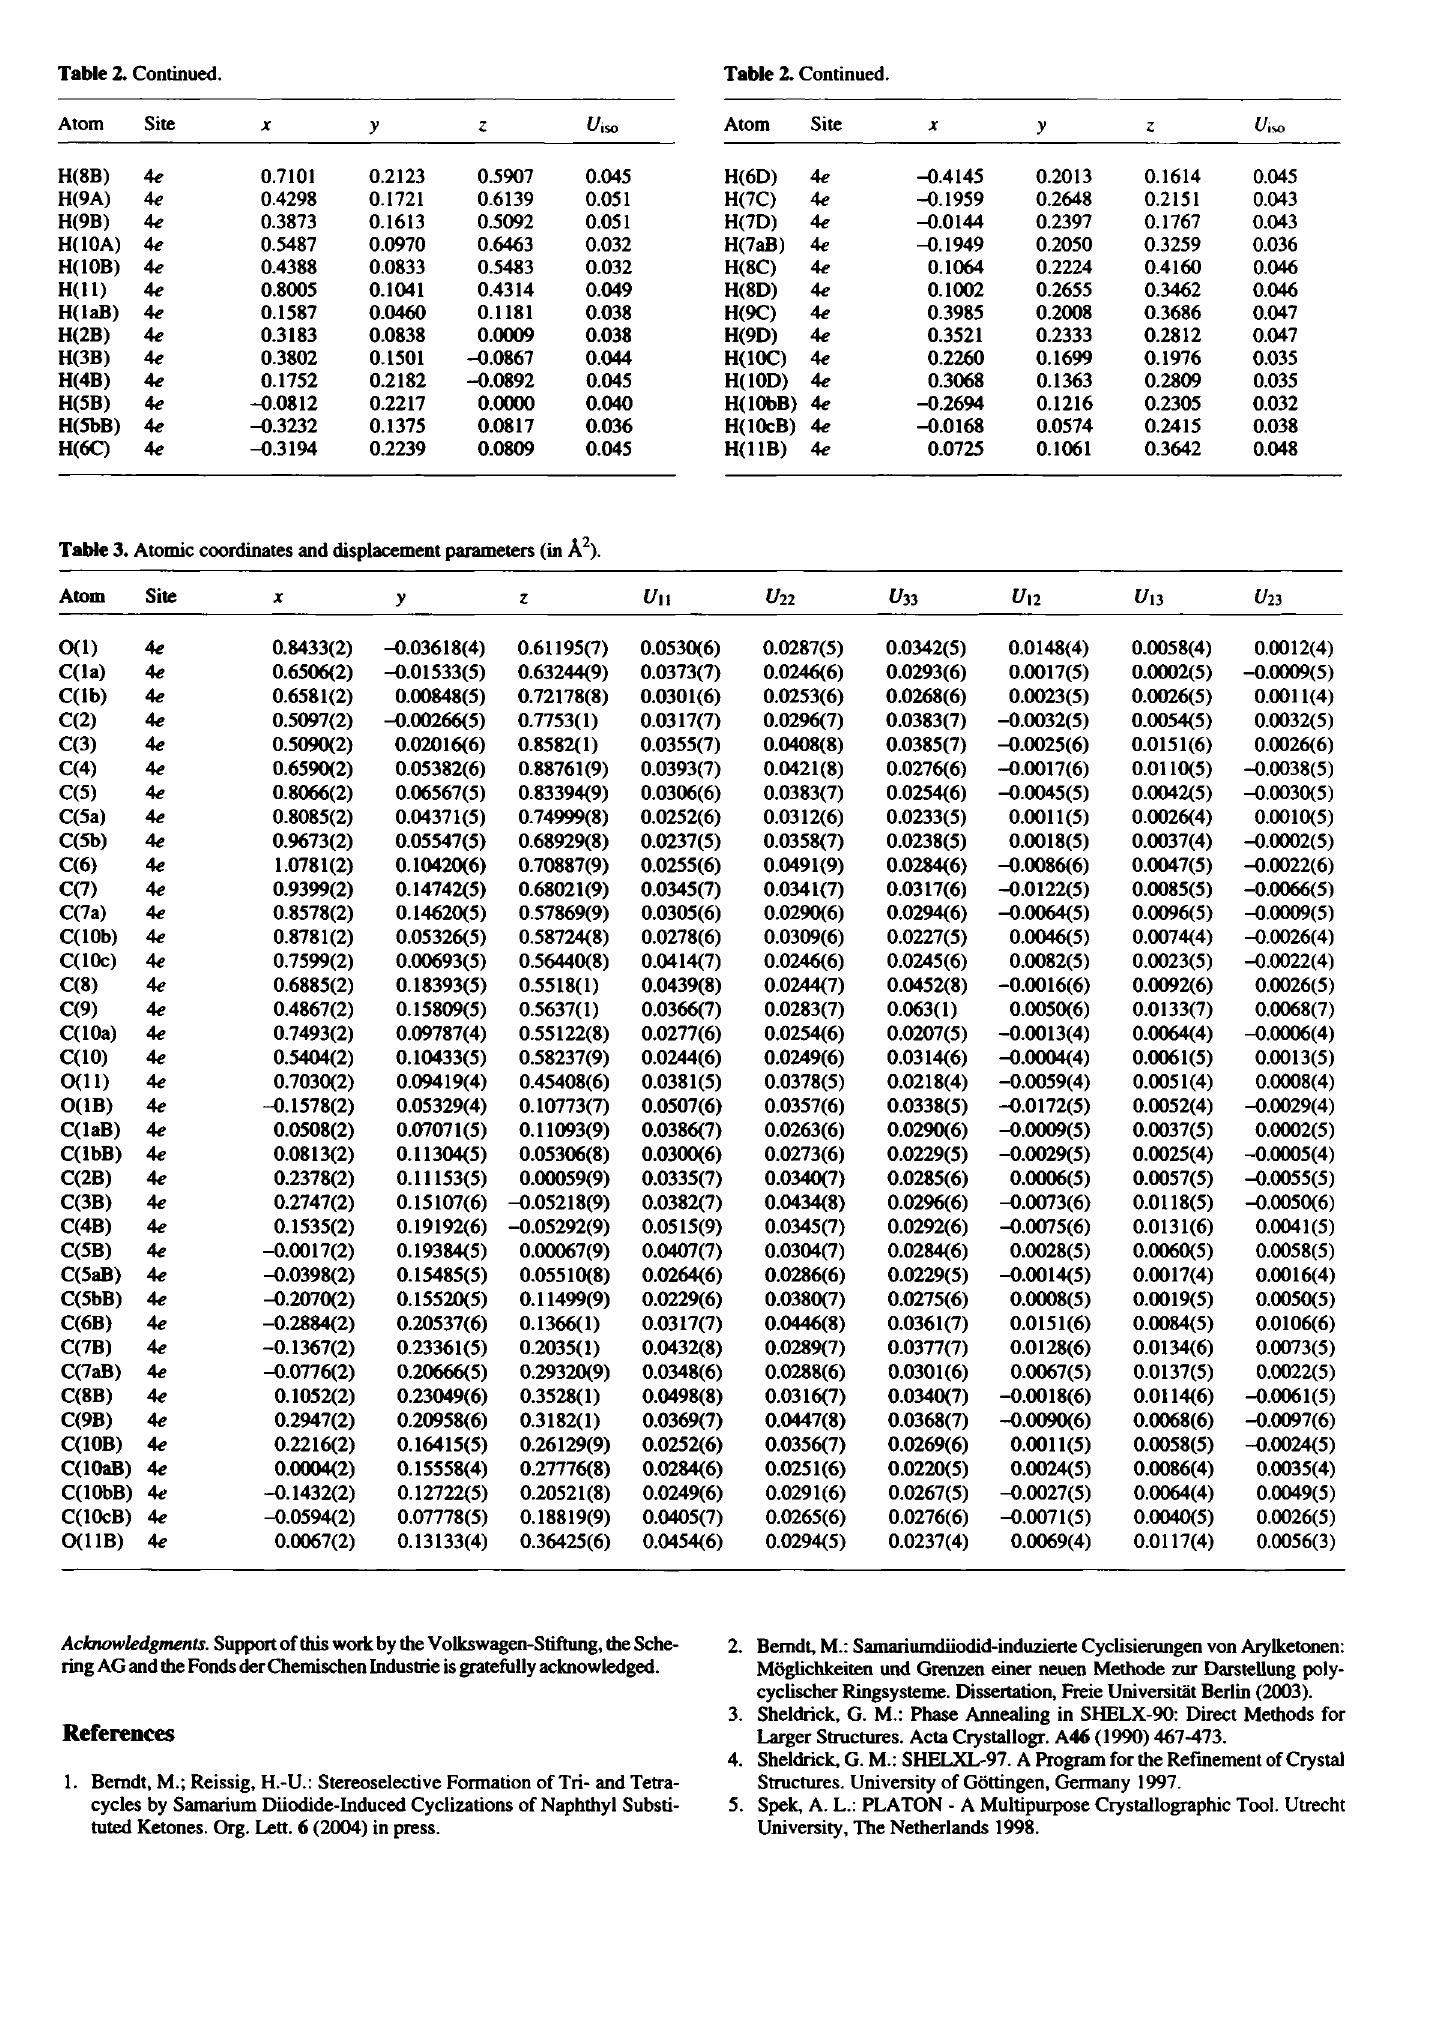
Table 3. Atomic coordinates and displacement parameters (in Â 2